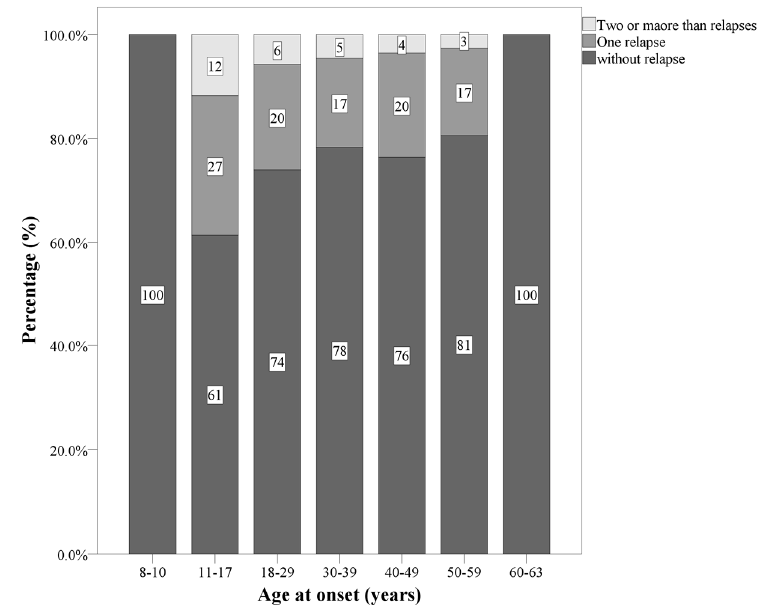
Figure 4. Number of relapses, separately for age ranges.